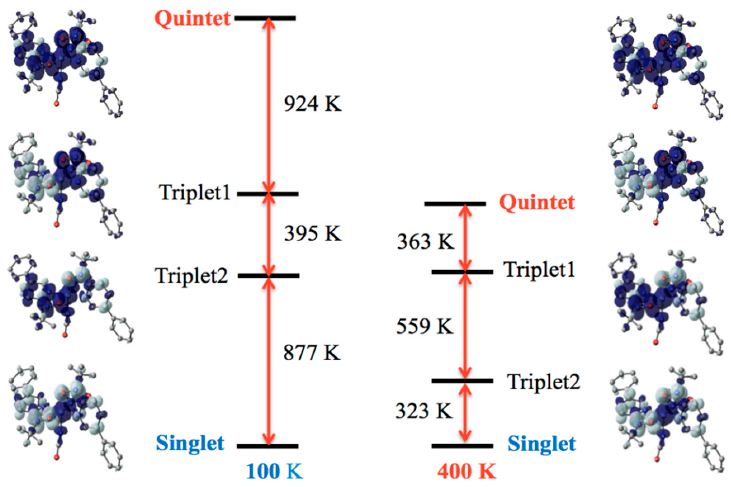
Figure 4. Diagram of the energy levels of the singlet, two triplet, and quintet states for the 100 K and 400 K forms of 4 . Molecules are shown with a spin density map superposed. H atoms are omitted. The positive (dark) and negative spin densities (light) are drawn with an isocontour of 0.002 e − Å − 3 .